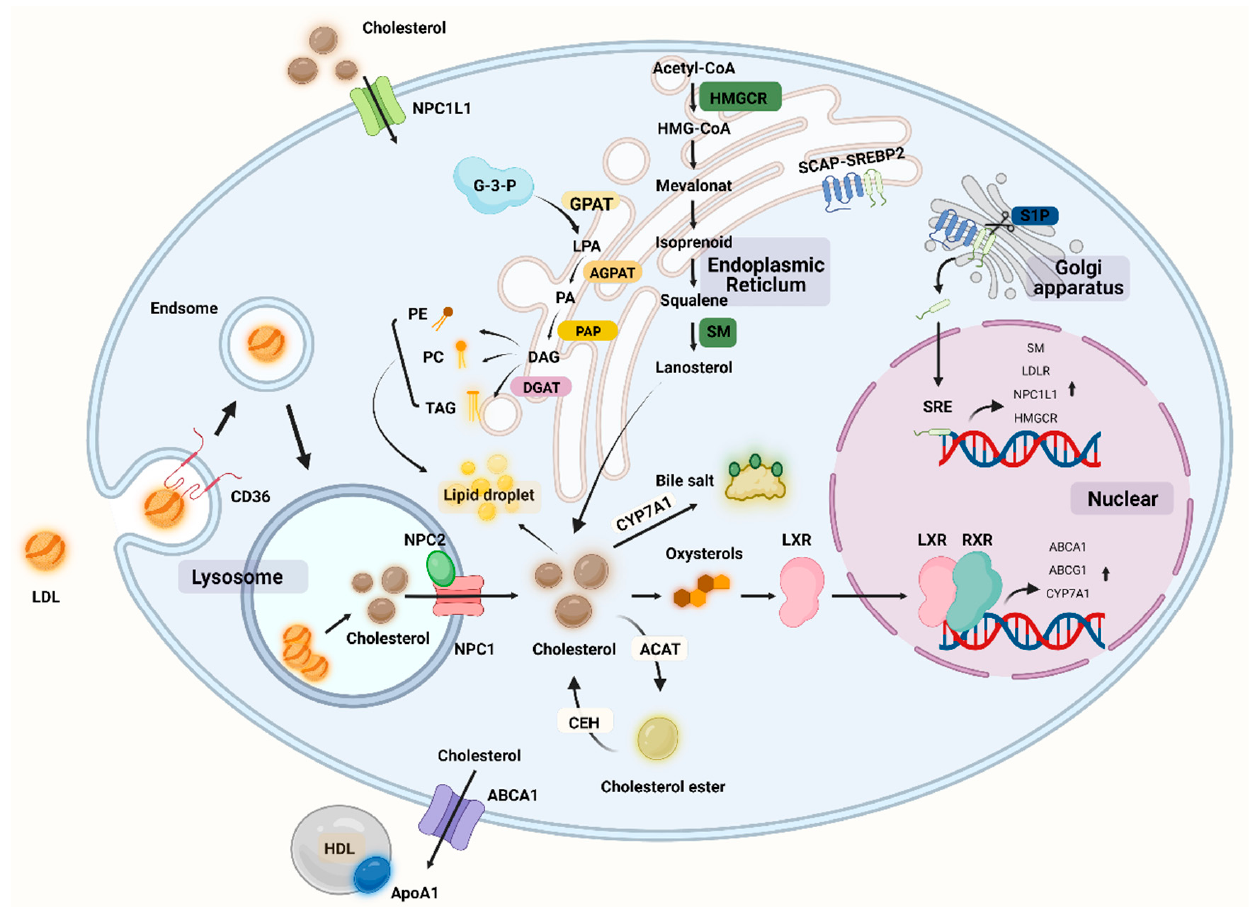
Figure 2. Overview of lipid metabolism in cells including chondrocytes. NPC1L1: Niemann–Pick C1-like 1, SM: squalene monooxygenase, HMGCR: hydroxymethylglutarate monoacyl coenzyme A reductase, HMG-CoA: 3-hydroxy-3-methylglutaryl-coenzyme A, CEH: cholesteryl ester hydrolase, ACAT: acyl coenzyme cholesterol acyltransferase, CYP7A1: cholesterol 7 α -hydroxylase, LXR: liver x receptor, RXR: retinoic acid X receptor, SCAP: SREBP cleavage activation protein, SREBP: sterol- regulatory element binding protein, TAG: triglyceride, PE: phosphatidylethanolamine, PC: phosphatidyl choline (lecithin), GPAT: glycerol-3-phosphate acyltransferase, AGPAT: lysophospholipid acyltransferase antibody, DGAT: diacylglycerol acyltransferase, G-3-P: glyceraldehyde 3-phosphate, LPA: lysophosphatidic acid, PA: phosphatidic acid DAG: glycerol diester, PAP: phosphatidic acid phosphatase. (Figure was created with Biorender.com and accessed 20 September 2022).